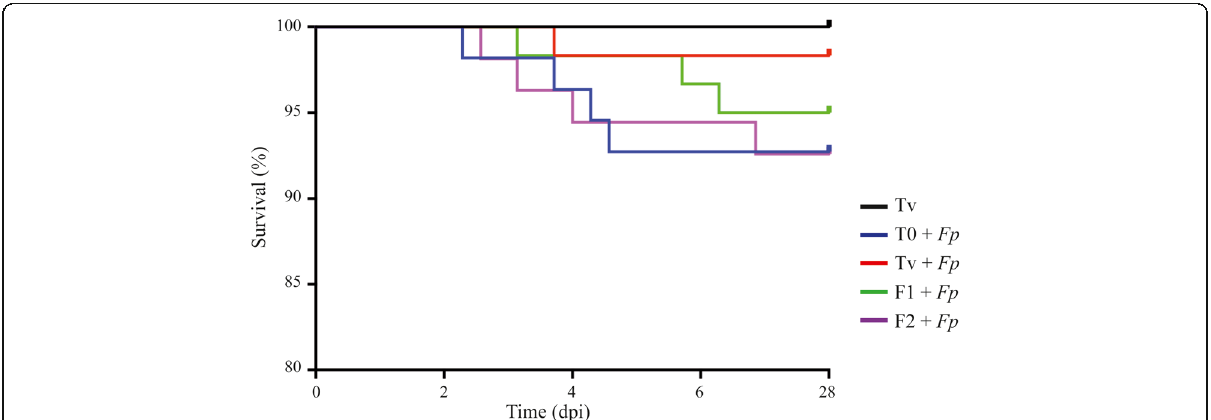
Fig. 6 Kaplan – Meier survival curves of rainbow trout following infection by immersion challenge with F. psychrophilum strain FRGDSA 1882/11. Fish fed the Tv, T 0 , F1, and F2 diets were infected for 24 h with 2 × 10 7 CFU mL − 1 in a final volume of 10 L. The results correspond to the survival percentage during 28 days post-infection (dpi) of two replicates ( n = 60 fish per condition). Kaplan-Meier survival data was analyzed by log-rank (Mantel-Cox)